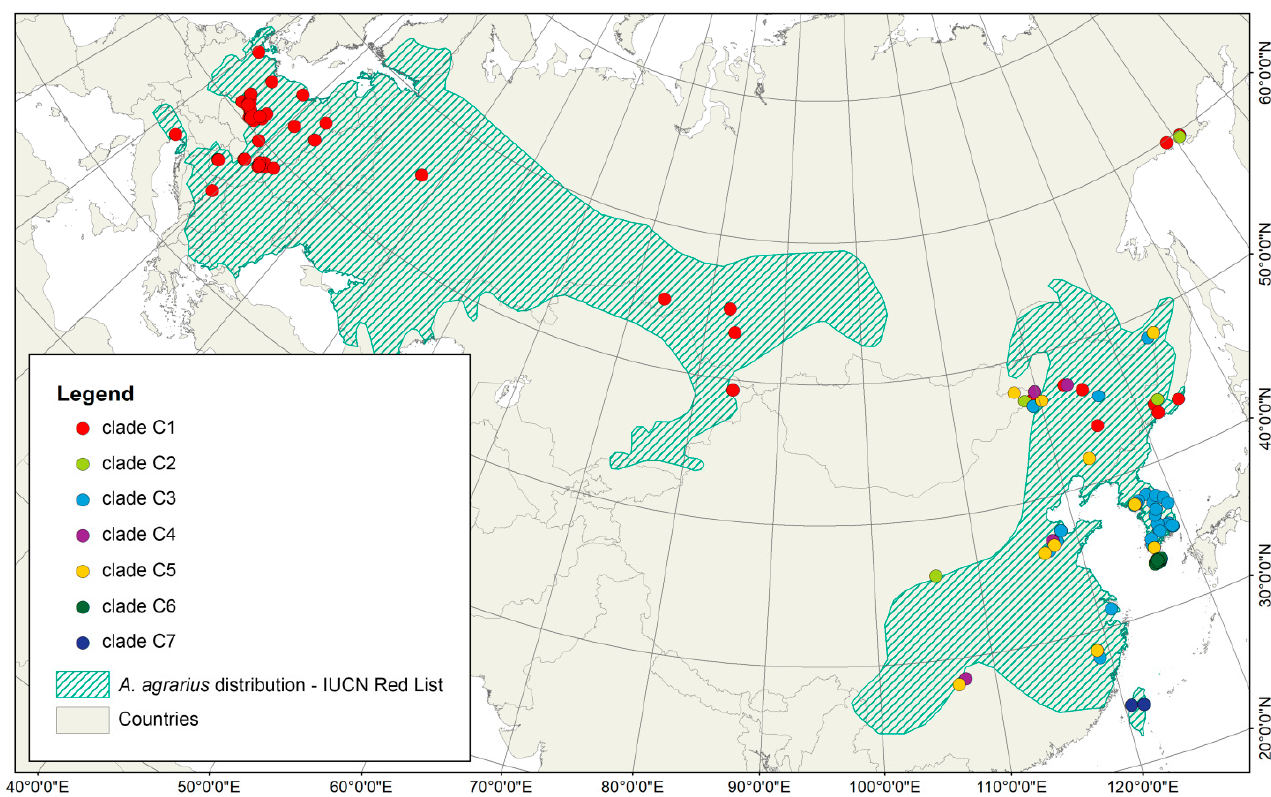
Figure 1. Origins of the samples used in the genetic analyses and their assignments to genetic clades of A. agrarius with geographic range of species, downloaded from IUCN Red List of Threatened Species. Version 2020-3.